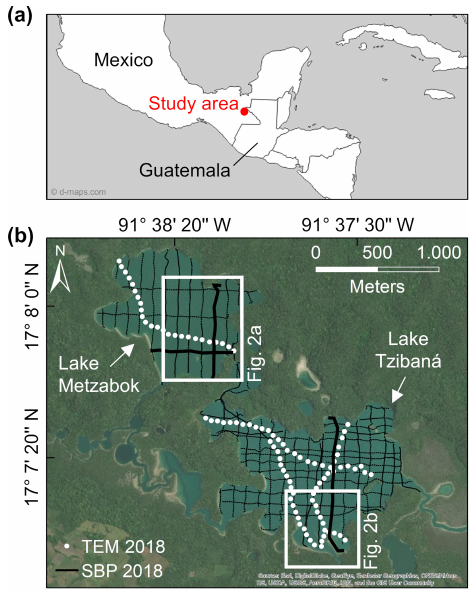
Figure 1. (a) Location of the study area in southern Mexico (from d-maps.com). (b) Layout of the geophysical survey on lakes Met- zabok and Tzibaná during high-level stands in March 2018. Black lines show the sub-bottom profiler (SBP) survey grid, bold lines highlight those profiles discussed in detail in this paper, white circles represent individual transient electromagnetic soundings (TEM). The optical satellite image in the background (©Microsoft) shows lake water surface similar to the high-level stands encoun- tered during March